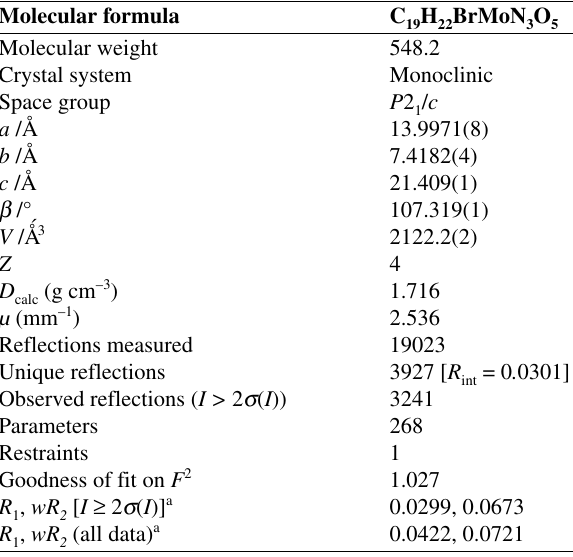
Table 1. Crystal and structure refinement data for the complex